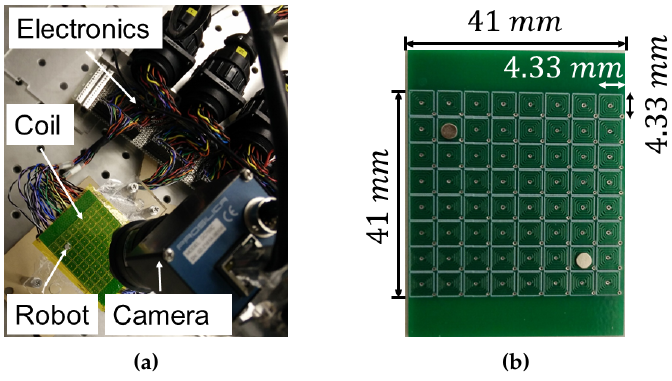
Figure 2. Experimental setup: ( a ) overall setup with integrated components, ( b ) closeup of the microcoil